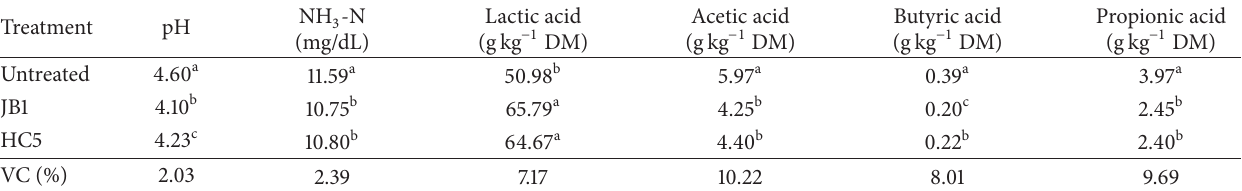
Table 3: Mean values of pH, NH 3 -N, and lactic, acetic, butyric, and propionic acids in Tanzania grass silage. Treatment